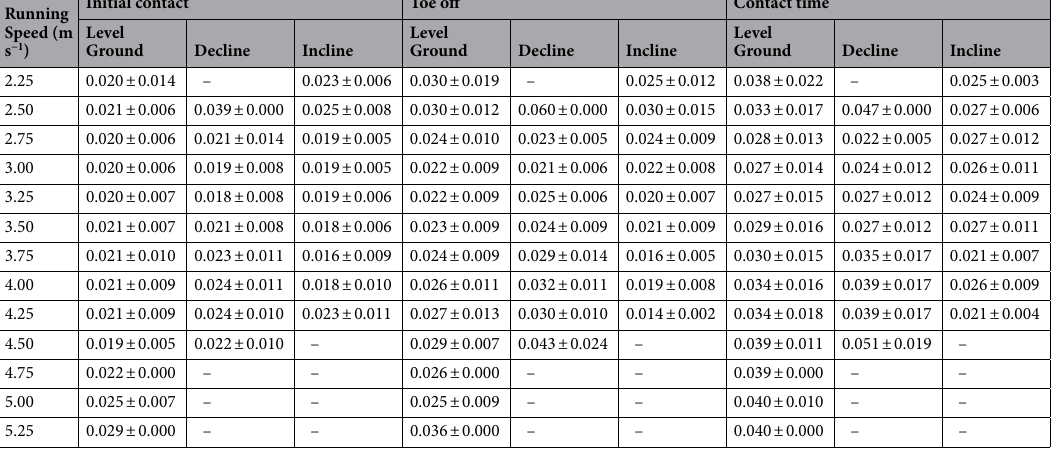
Table 3. BD-LSTM temporal variable